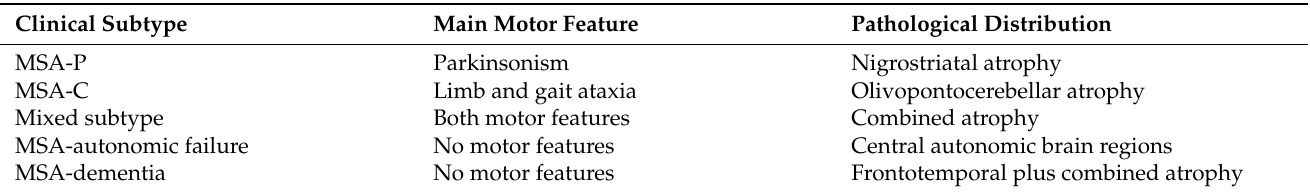
Table 1. Clinical variants of multiple system